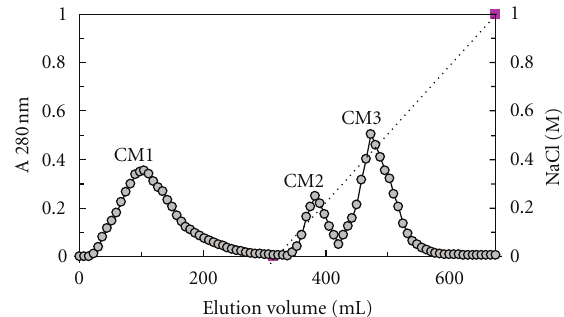
Figure 1: Ion exchange chromatography on CM-cellulose column (2 . 5 × 20 cm). Sample: fraction of Lentinus tigrinus incubation broth that was adsorbed on DEAE-cellulose. Fraction size: 8mL. Starting bu ff er: 10 mM NH 4 OAc bu ff er (pH 4.5). Dotted line across right-hand side of chromatogram indicates linear NaCl concentration (0-1M) gradient used to CM2 and CM3.